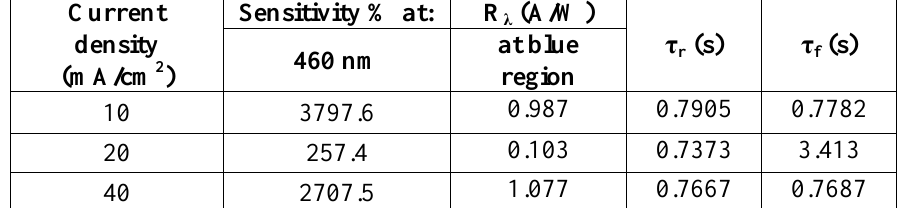
Fig.9: Sensitivity, responsivity, rise and fall times of the p-PS photo sensors under the wavelength of 460 nm without applied voltage at different etching current densities. Table5: The sensitivity, rise and fall times values for p-PS with different etching current